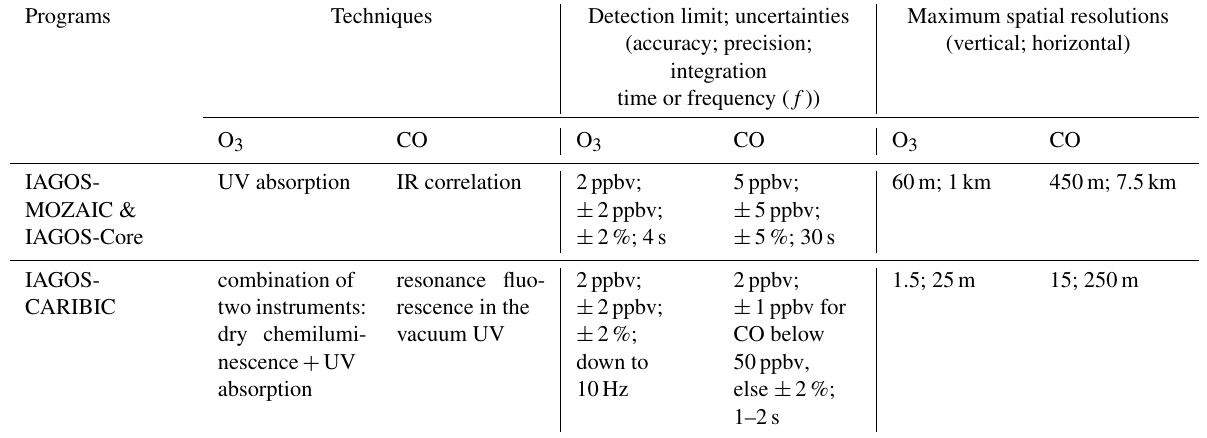
Table 3. Summary of the CO and O 3 instrument characteristics. Maximum spatial resolutions are just indicative values and are given for civil-aircraft-approximated maximum ascent and descent speed of 15 and 250ms − 1 during cruise.